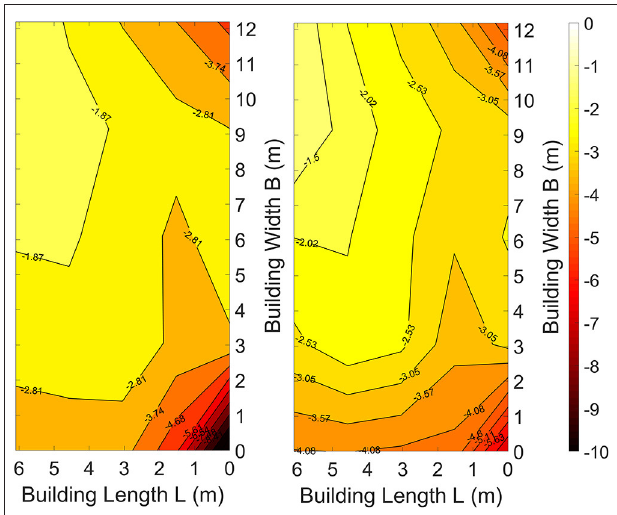
TABLE 4 | Summary of results for the ridge areas.